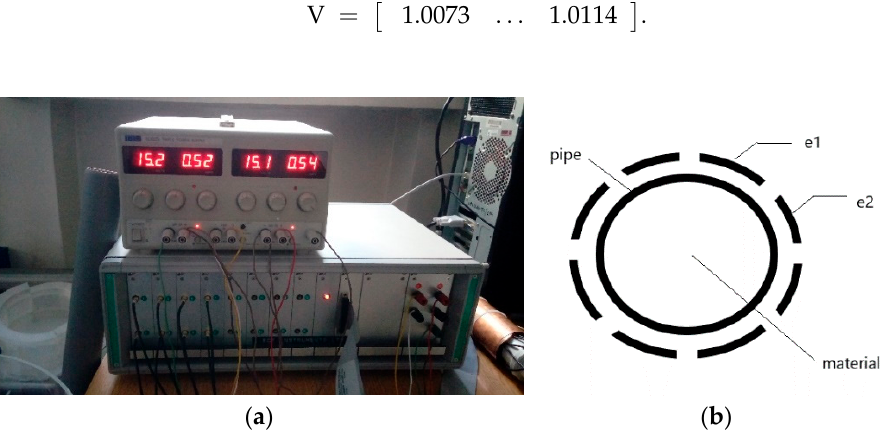
Figure 3. Electrical capacitance tomography measurement unit and sensor placing on the pipe ( a ). On the right hand, the cross-section of the pipe is presented with electrodes (e1, e2 …) mounted around the pipe ( b ).